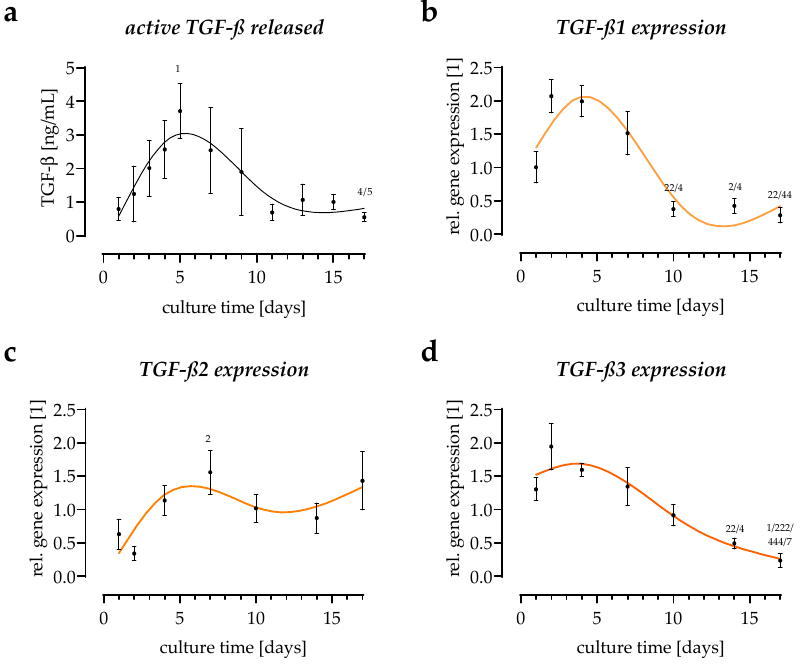
Figure 3. Expression and secretion of TGF- β over time. ( a ) Active TGF- β released from the in vitro scabs into the culture supernatants was detected with an adenoviral-based reporter assay. N = 4, n = 2. ( b – d ) Expression of the three TGF- β isoforms. Expression was determined at days 1, 2, 4, 7, 10, 14, and 17 of culture. N = 4, n = 2. X p < 0.05 and XX p < 0.01, and XXX p < 0.001 as compared to day